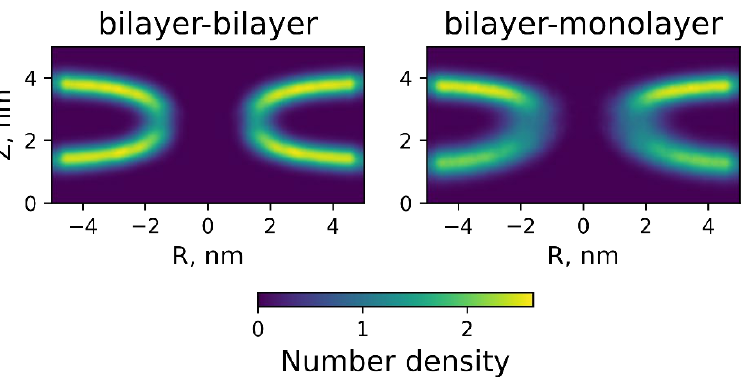
Figure 7. The number density of the phosphate group at lipid stalk for bilayer–bilayer ( left ) and bilayer–monolayer ( right ) systems.